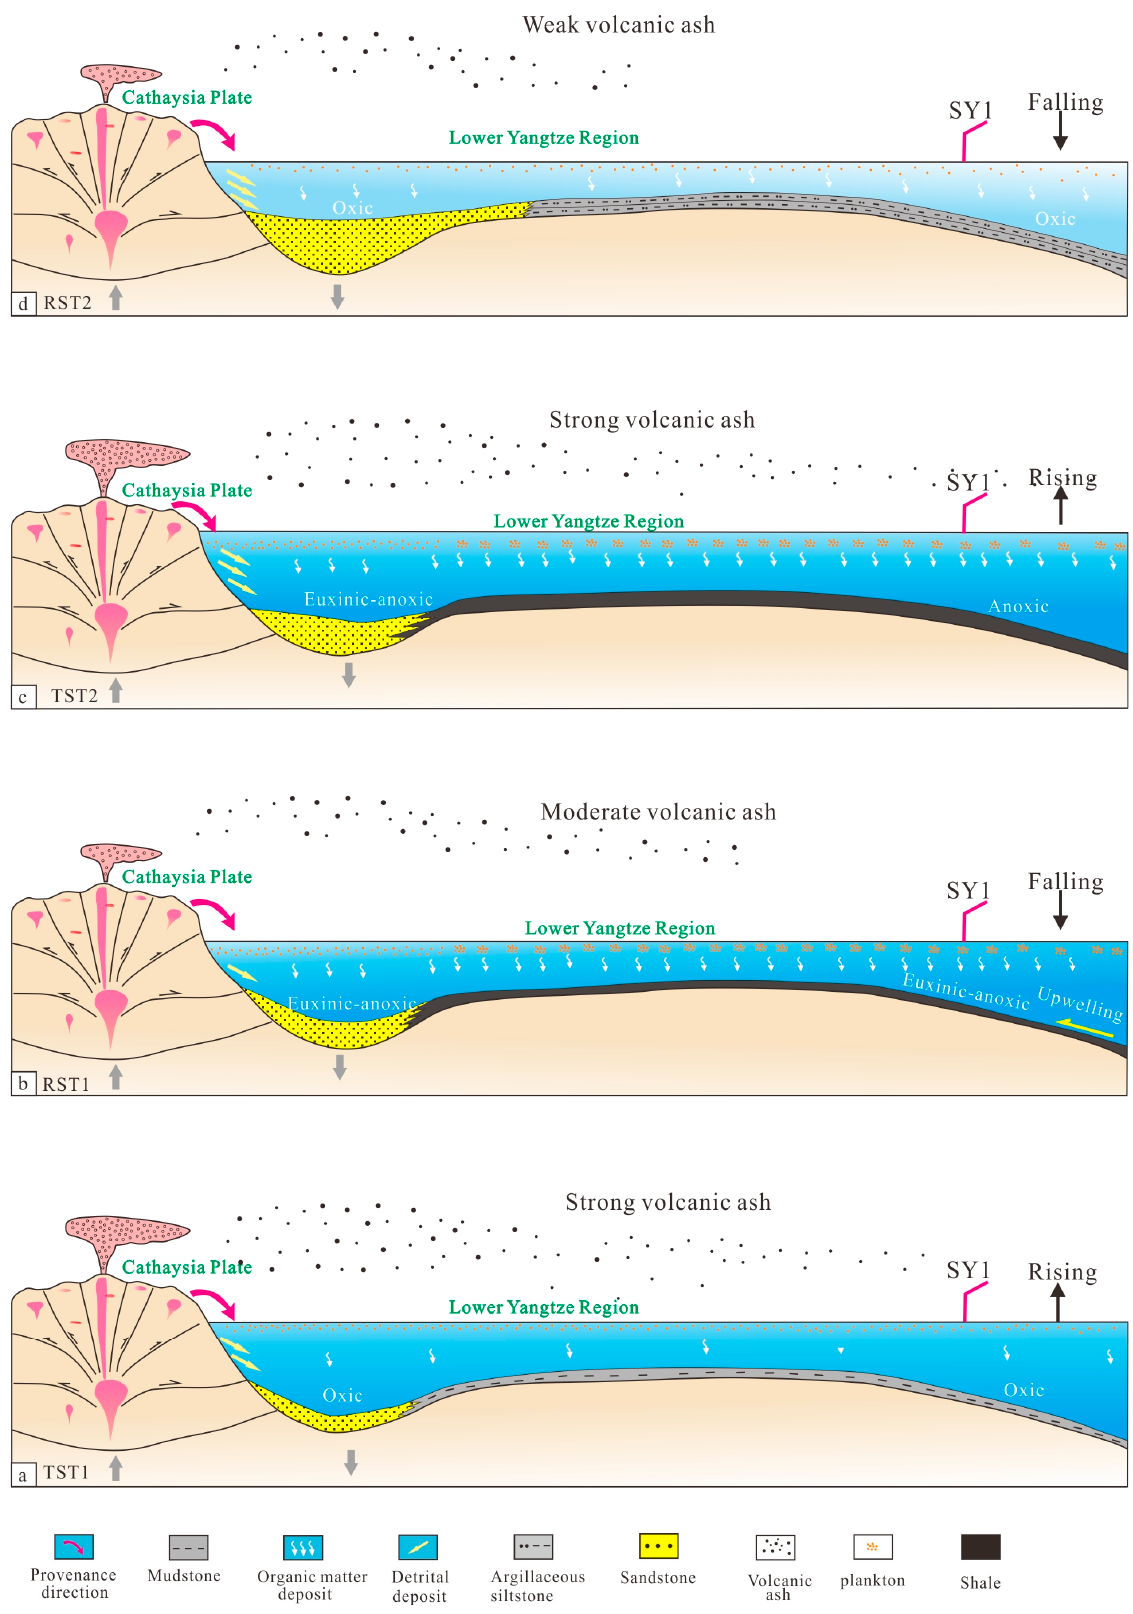
Figure 11. Schematic diagrams demonstrating the distinct OM accumulation models patterns of different systems tract in the Lower Yangtze region during O/S transition. ( a ) Stage of TST1, ( b ) Stage of RST1, ( c ) Stage of TST2, and ( d ) Stage of